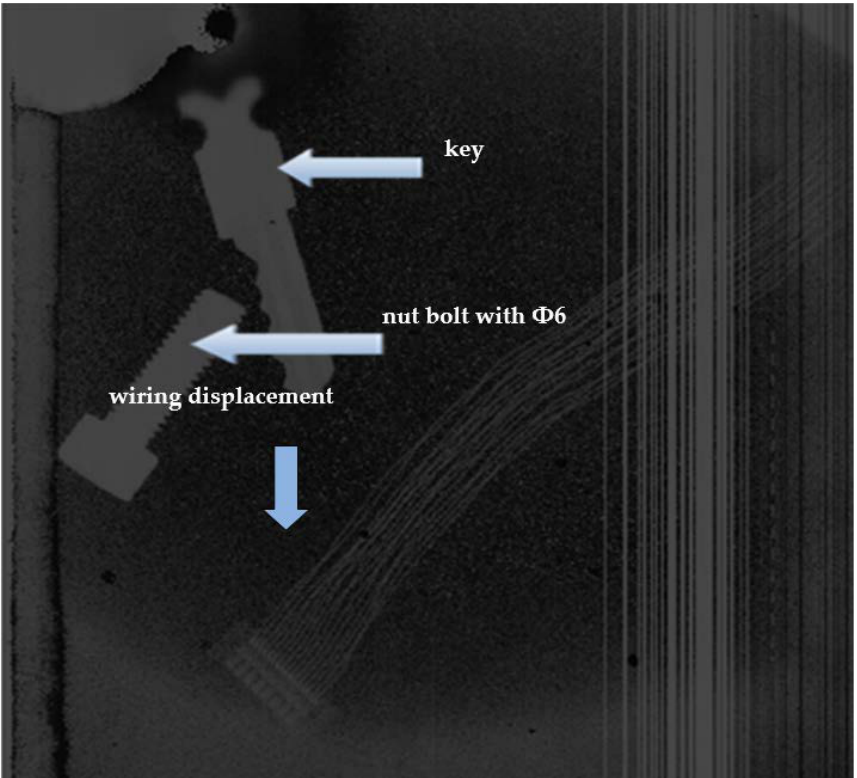
Figure 5. Bolt, key, and wiring displacement image taken by X-ray Planar Images.